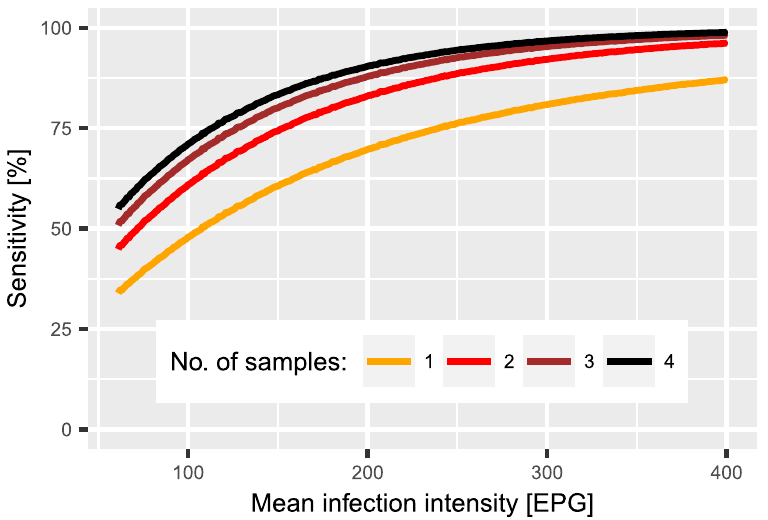
Fig 4. Estimated relation between sensitivity and arithmetic mean S. mansoni infection in a population with α = 0.07 and r = 1.0 for one to four samples.